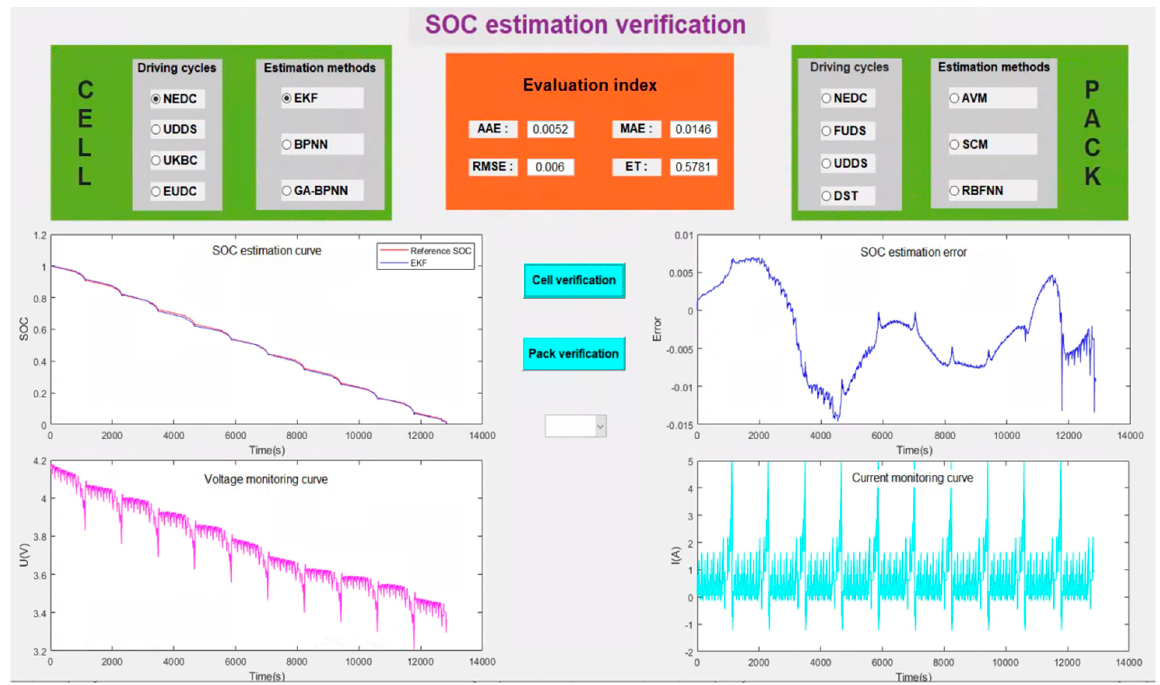
Figure 14. Verification results of the offline SOC estimation.